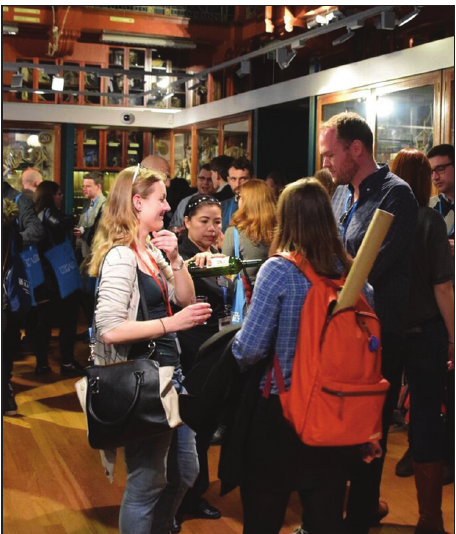
Figure 5: Delegates at the UK Archaeological Science (UKAS) conference at the welcome wine reception hosted in the Grant Museum of Zoology (Photo Jen